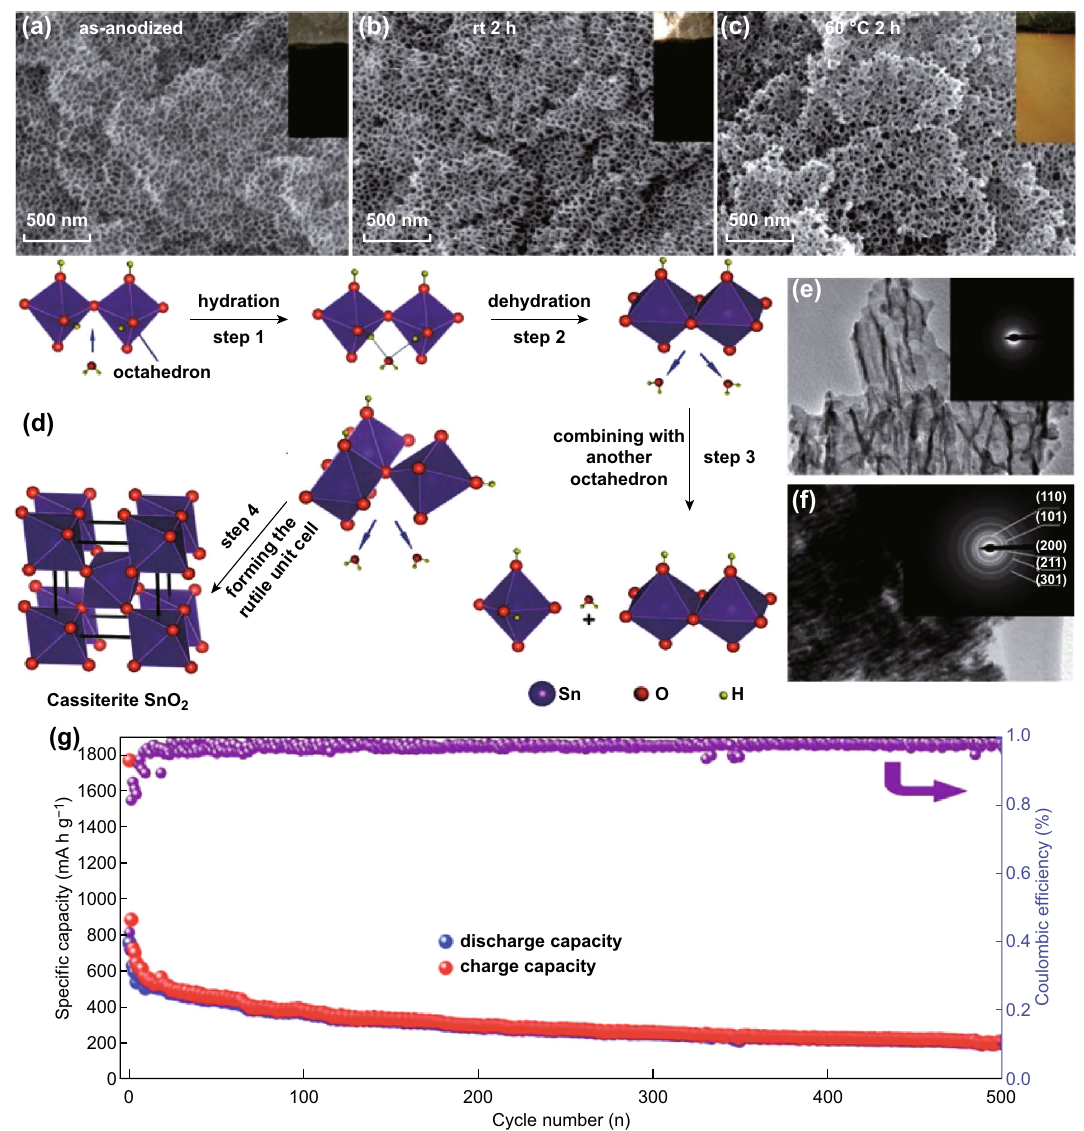
Fig. 18 SEM images of the as-anodized SnO 2 samples a before and b after soaking in water for 2 h at room temperature and c after soaking in water for 2 h at 60 (cid:3) C. The insets are the photographs showing the appearance of the corresponding SnO 2 samples. d Schematic illustration showing the transformation from amorphous to rutile SnO 2 assisted by water soaking. TEM images of the SnO 2 samples e as-anodized and f after water soaking at 60 (cid:3) C for 2 h; the insets show the corresponding SAED patterns. g Long-term stability profiles and Coulombic efficiency of the water-crystallized SnO 2 at 0.3 C for 500 cycles [159]. Copyright (cid:2) 2015 WILEY–VCH Verlag GmbH & Co. KGaA,